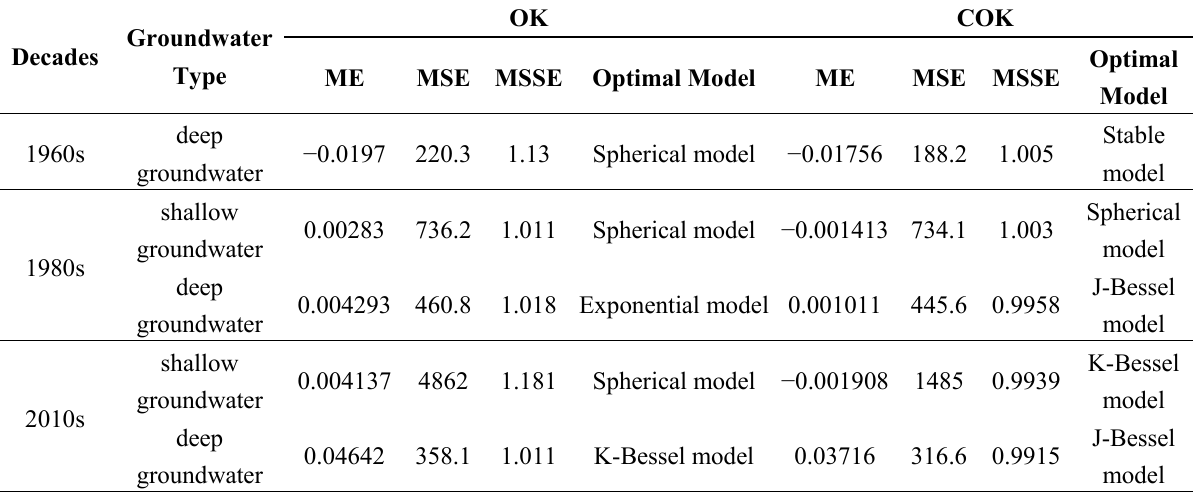
Table 4. Cross-validation results of TDS determined by ordinary kriging (OK) and co-kriging (COK). MSSE, mean-square standard